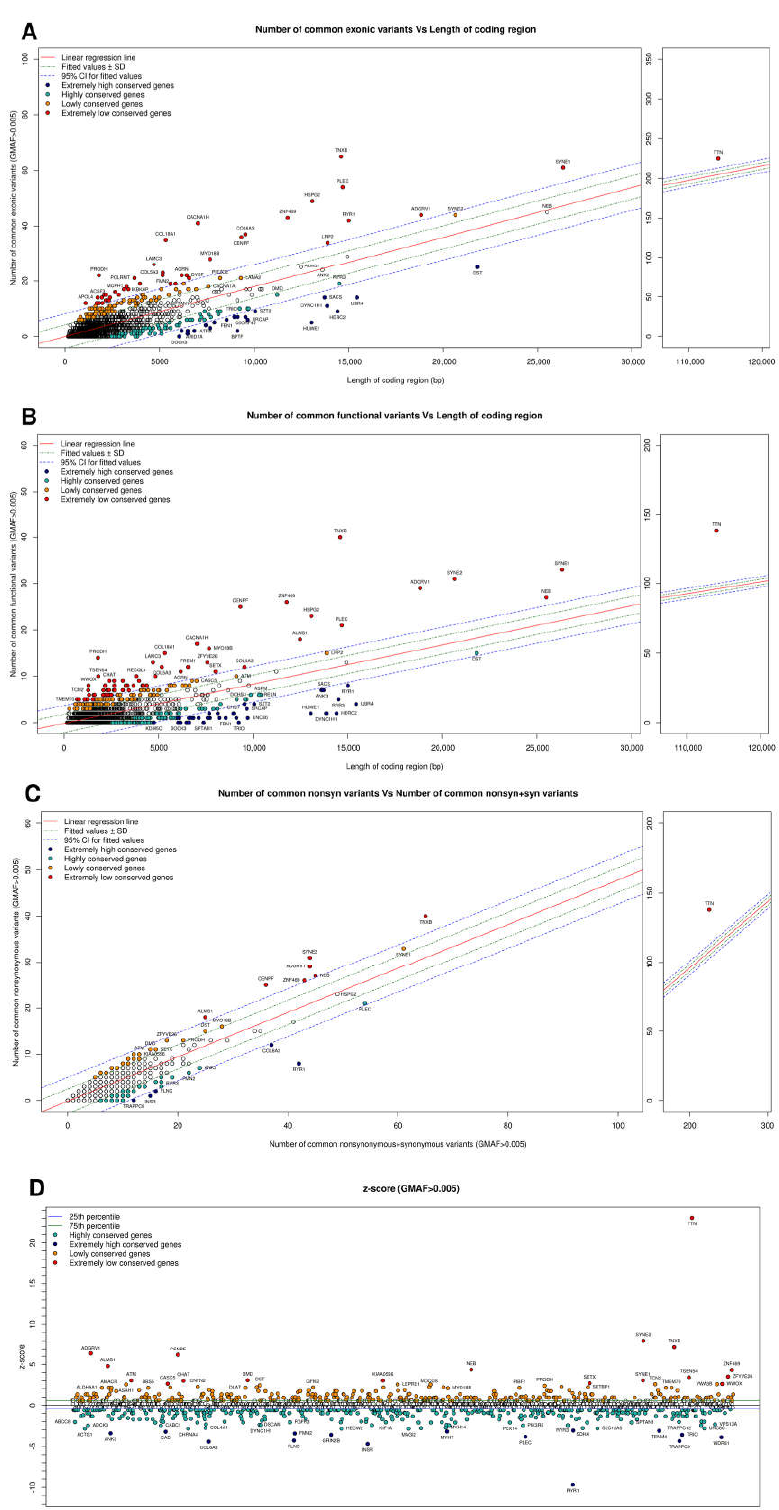
Figure 1. ( A ) Regression of number of common exonic variants (GMAF > 0.5%) against gene length for each of the 1670 genes analyzed; ( B ) Regression of number of common functional variants (all but synonymous, GMAF > 0.5%) against gene length for each gene; ( C ) Regression of number of non-synonymous common variants against number of non-synonymous and synonymous common variants (GMAF > 0.5%) for each gene; ( D ) z -score values for all analyzed genes.